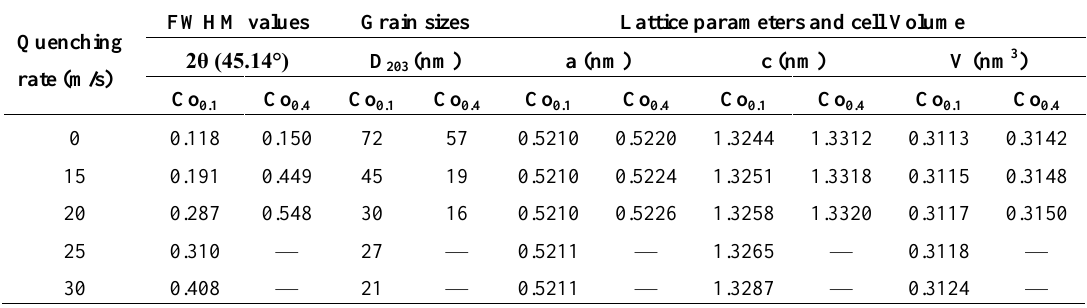
and Co alloys. 0.1 0.4